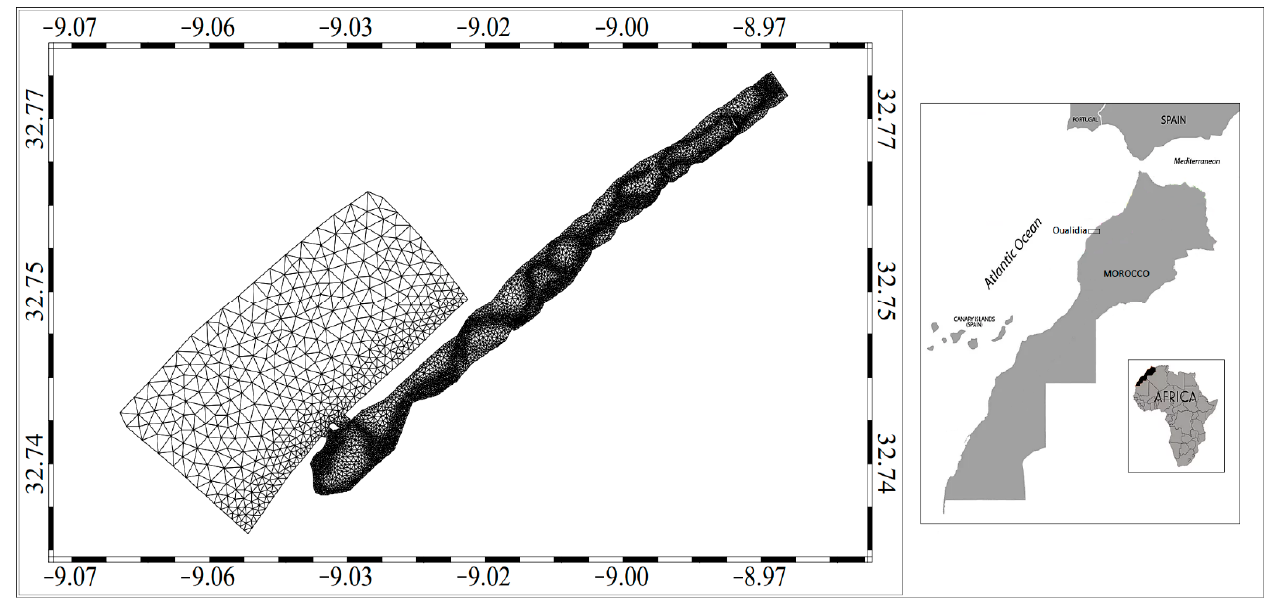
Figure 1. Grid of the study area ‘Oualidia’ lagoon and its location.